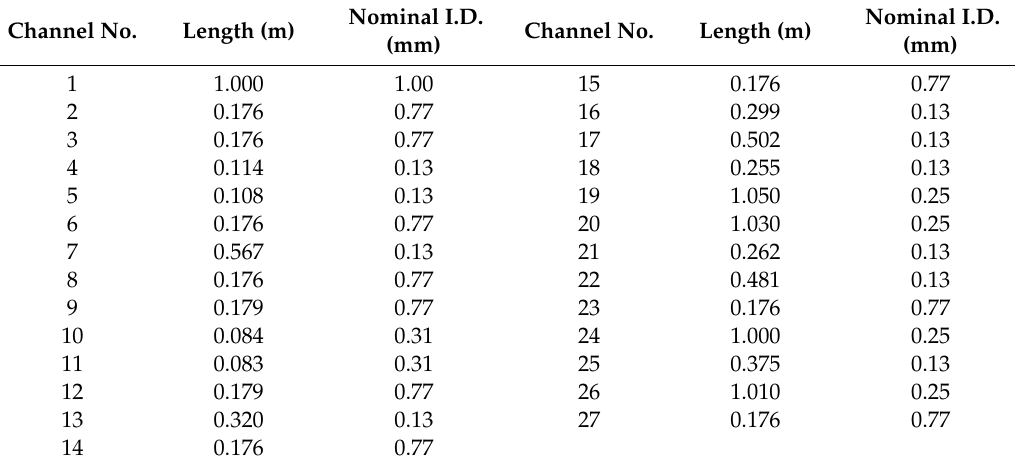
Table 3. Sizes of channels in the SRFD.